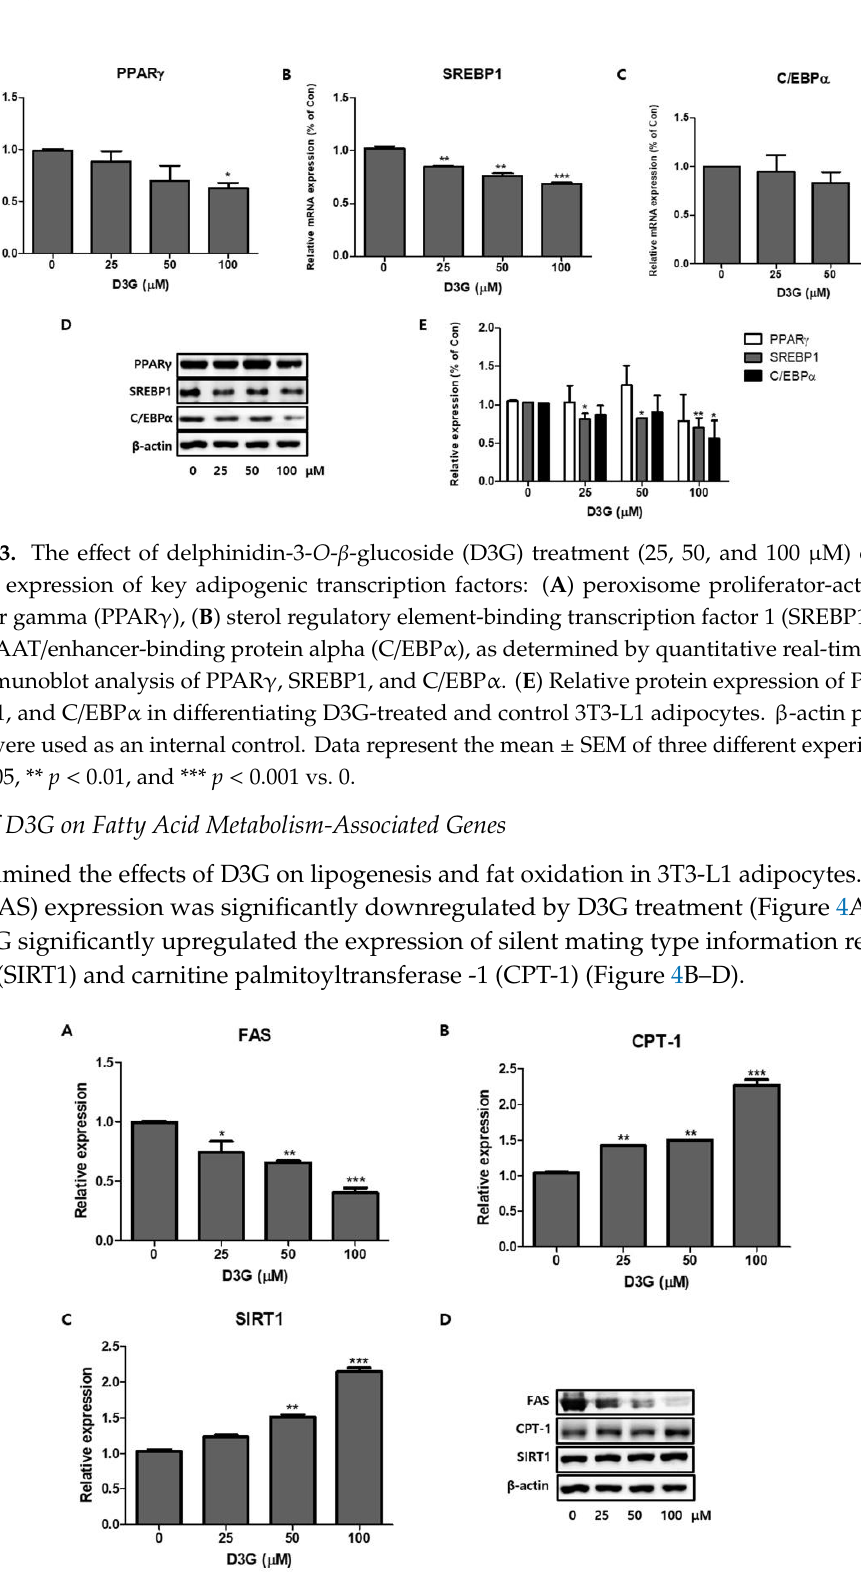
Figure 4. The e ff ect of delphinidin-3- O - β -glucoside (D3G) treatment on the protein expression of ( A ) Fatty acid synthase (FAS), ( B ) carnitine palmitoyltransferase -1 (CPT-1), and ( C ) silent mating type information regulation 2 homolog 1 (SIRT1) in 3T3-L1 adipocytes. ( D ) Representative immunoblot image of FAS, CPT-1, and SIRT1 expression. β -actin protein levels were used as an internal control. * p < 0.05, ** p < 0.01, and *** p < 0.001 vs. 0. All experiments were repeated at least three times and data represent the mean ±